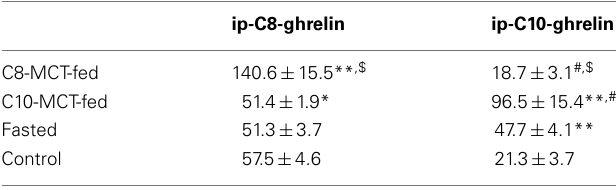
Table 1 | Numbers of immunopositive cells for C8- or C10-ghrelin in stomachs of